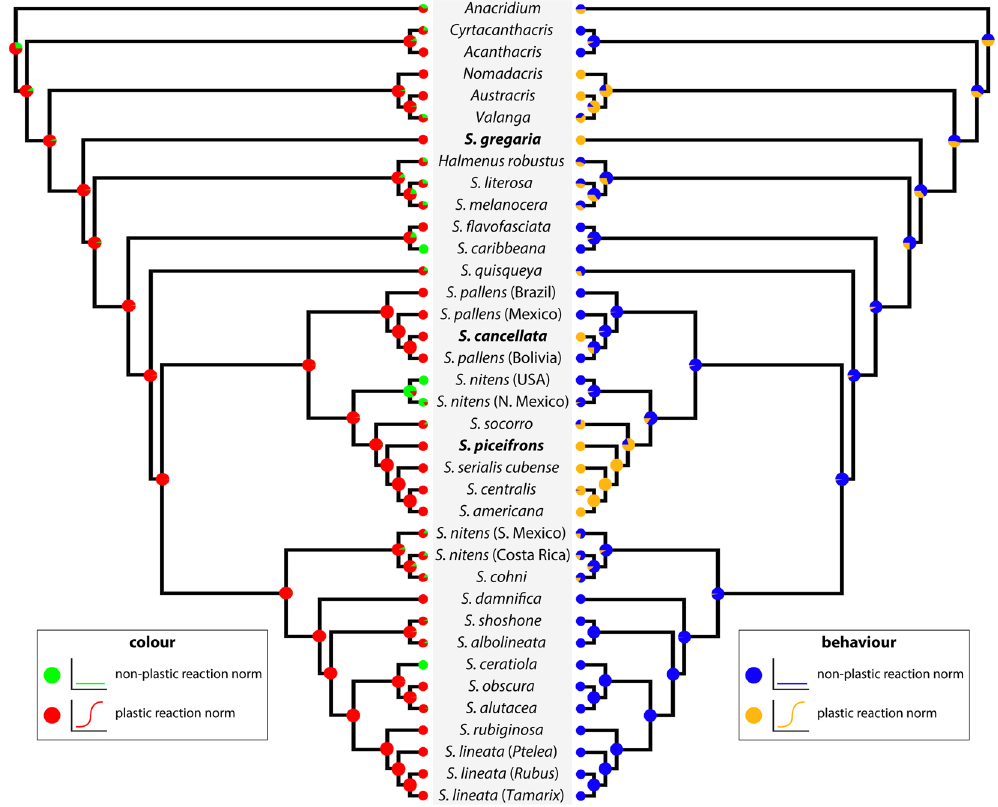
Figure 4. Ancestral character state reconstruction using stochastic character mapping. The left tree shows the evolution of density-dependent reaction norm in nymphal colouration and the right tree shows the evolution of density-dependent reaction norm in behaviour. The pie chart-like symbols on the nodes represent the probability of ancestral character state. The species in bold face indicate swarming